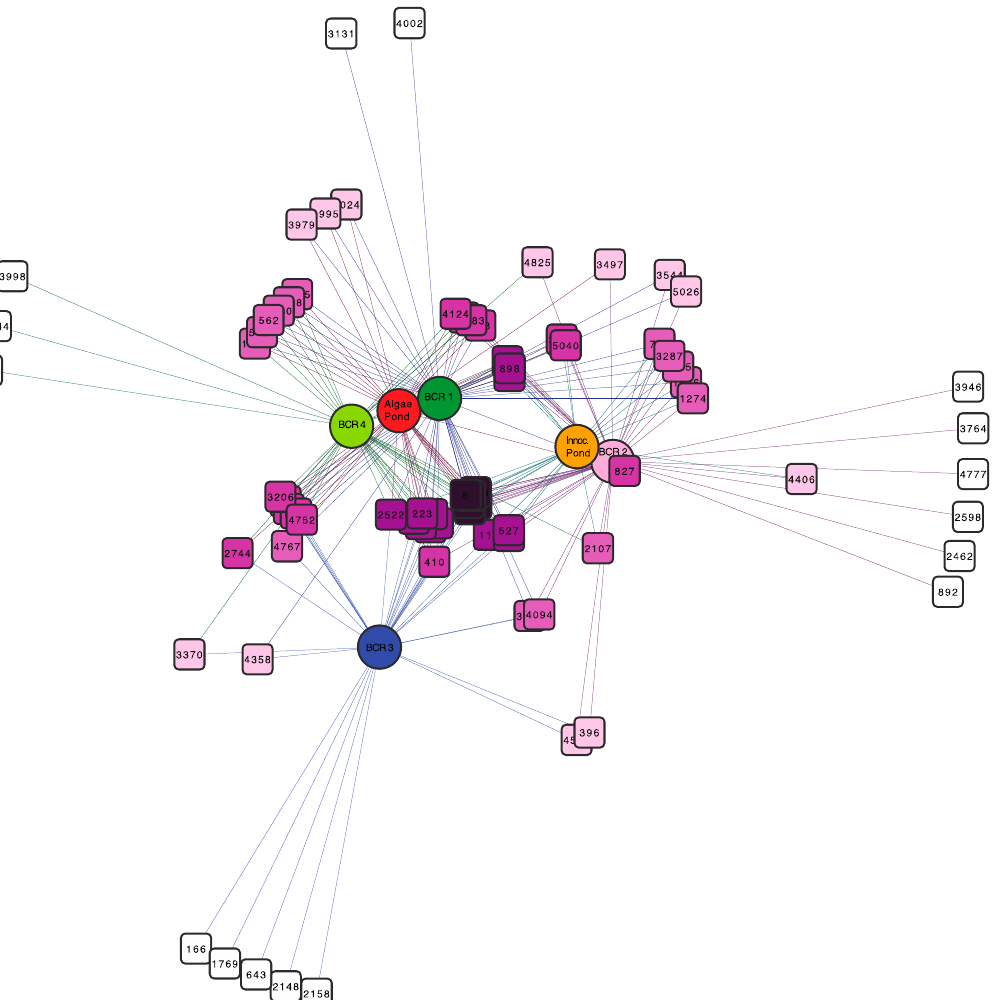
Figure 5. Bipartite network of methanogenic-related OTUs and samples. Legend is the same as in Figure 4.